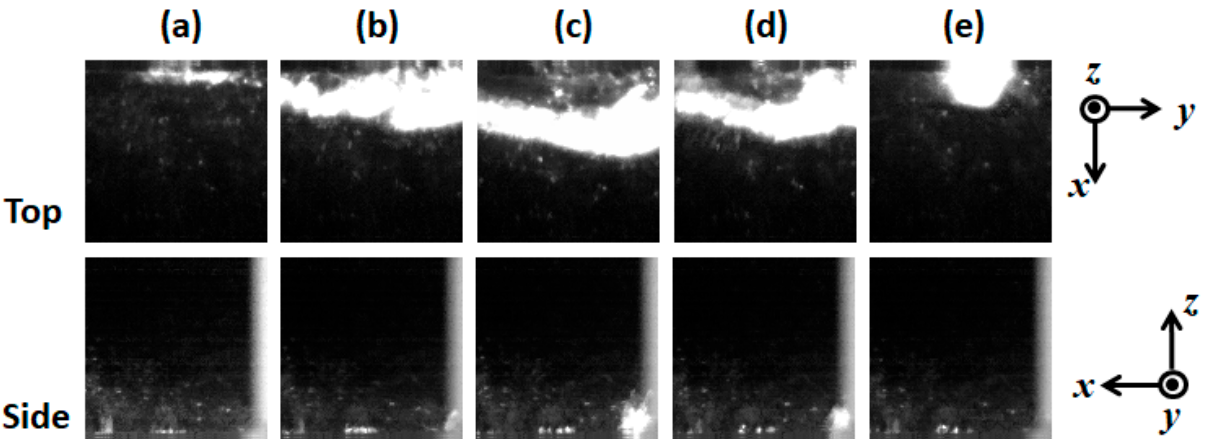
Figure 11. Instantaneous visualization using the synchronized signal with two high-speed cameras at a heat flux of 4.4 MW/m 2 : ( a ) 804.4 ms, ( b ) 804.7 ms, ( c ) 805.2 ms, ( d ) 805.5 ms, and ( e ) 805.7 ms.